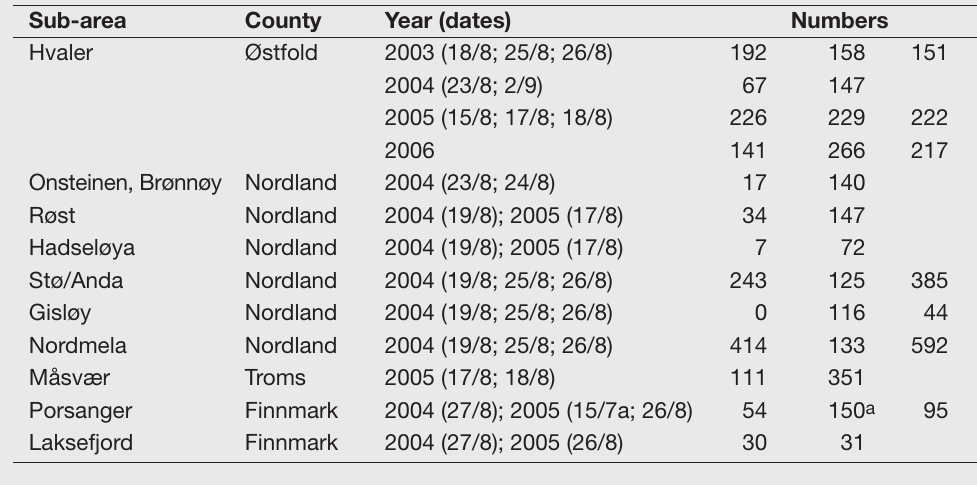
Table 2. Numbers of harbour seals observed in aerial photographic counts in sub-areas where 2-3 independent surveys were conducted during the moult within the same year.